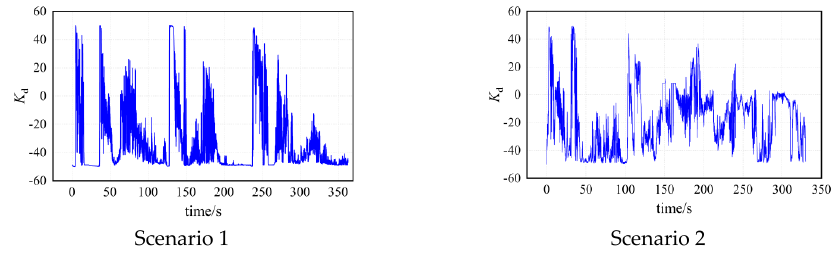
Figure 16. Zigzag and circle path following, heading angle, rudder angle, and 𝐾 p , 𝐾 d curves. It can be seen from the simulations that the SAC-auto controller has a better perfor- mance in both heading control and rudder maneuvering under the condition of path fol- lowing of zigzag and turning when considering the disturbance of the wave. The fluctua- tion of the rudder angle with SAC-auto is the smoothest, indicating that the SAC-auto